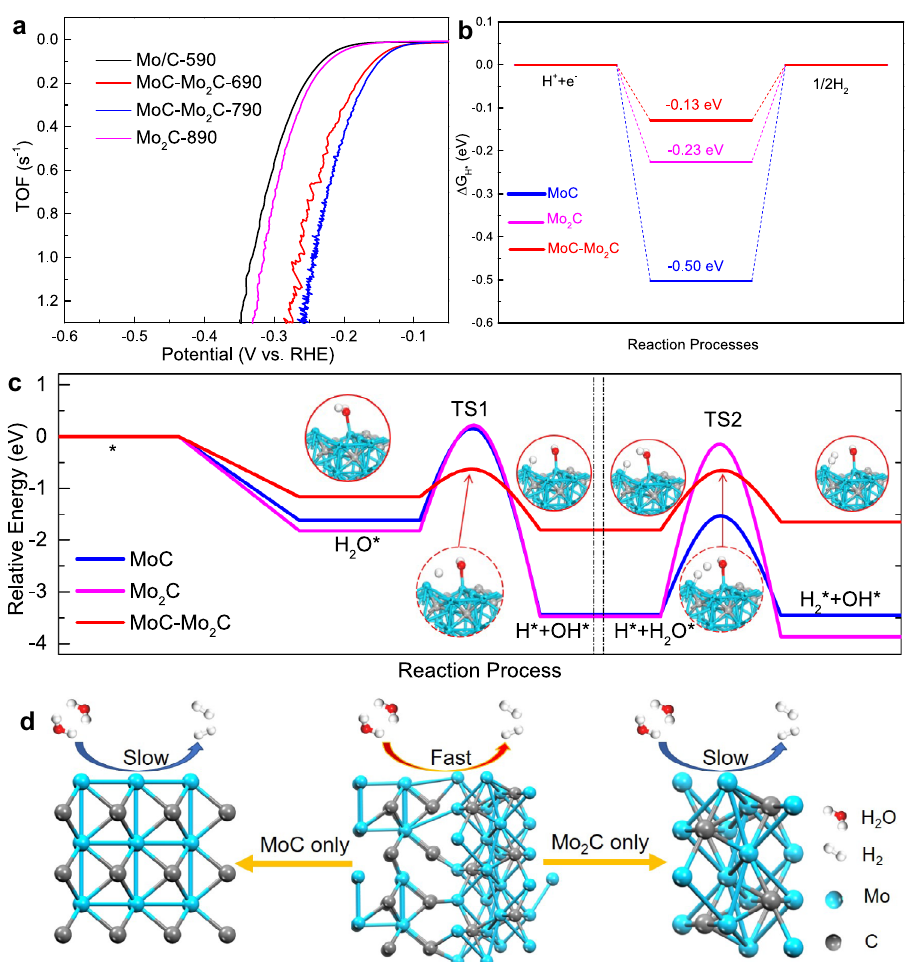
Fig. 3 TOF LSV curves and DFT calculations. a TOF LSV curves of different electrodes. b Calculated Δ G H* diagram of the HER in acid electrolyte at the equilibrium potential. c Relative energy diagram of water dissociation on MoC, Mo 2 C, and MoC-Mo 2 C, including the two steps of water dissociation, in alkaline solution, TS: Transition State. d Schematic illustration of the HER